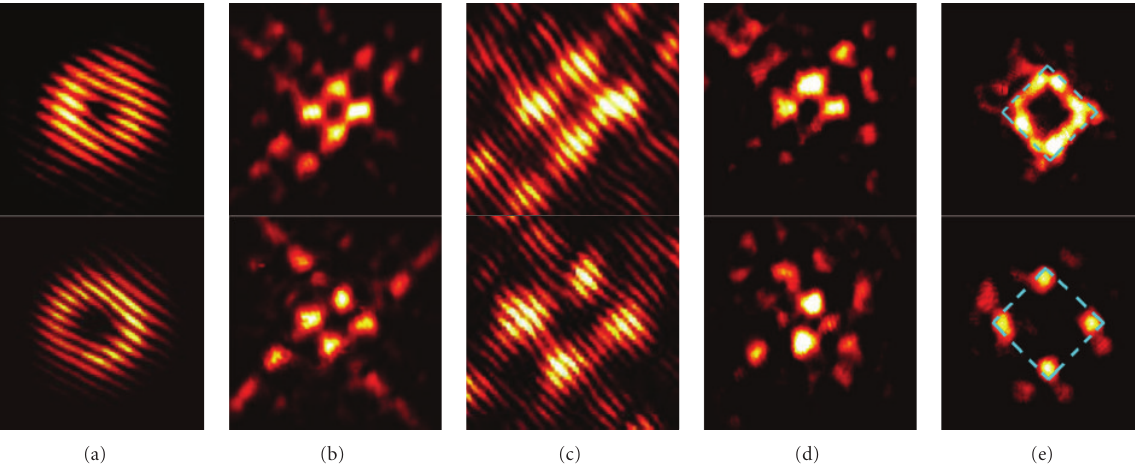
Figure 2: Experimental results of self-trapping of SCVs (top) and DCVs (bottom) in a defocusing photonic lattice. (a) Interferograms showing the phase of the input vortex beams, (b) intensity patterns of self-trapped vortex beams at lattice output, (c, d) interferograms between (b) and a tilted plane wave (c) and an on-axis Gaussian beam (d), respectively, and (e) the k -space spectra of (b) where the dash squares mark the first Brillouin zone of the square lattice. (a, c) are zoomed in with respect to (b, d) for better